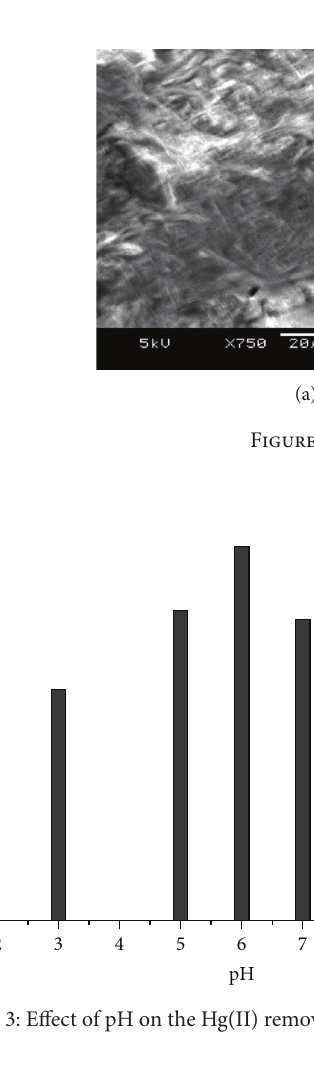
Figure 4: Effect of adsorbent dose with time on the removal of Hg(II) by ALP